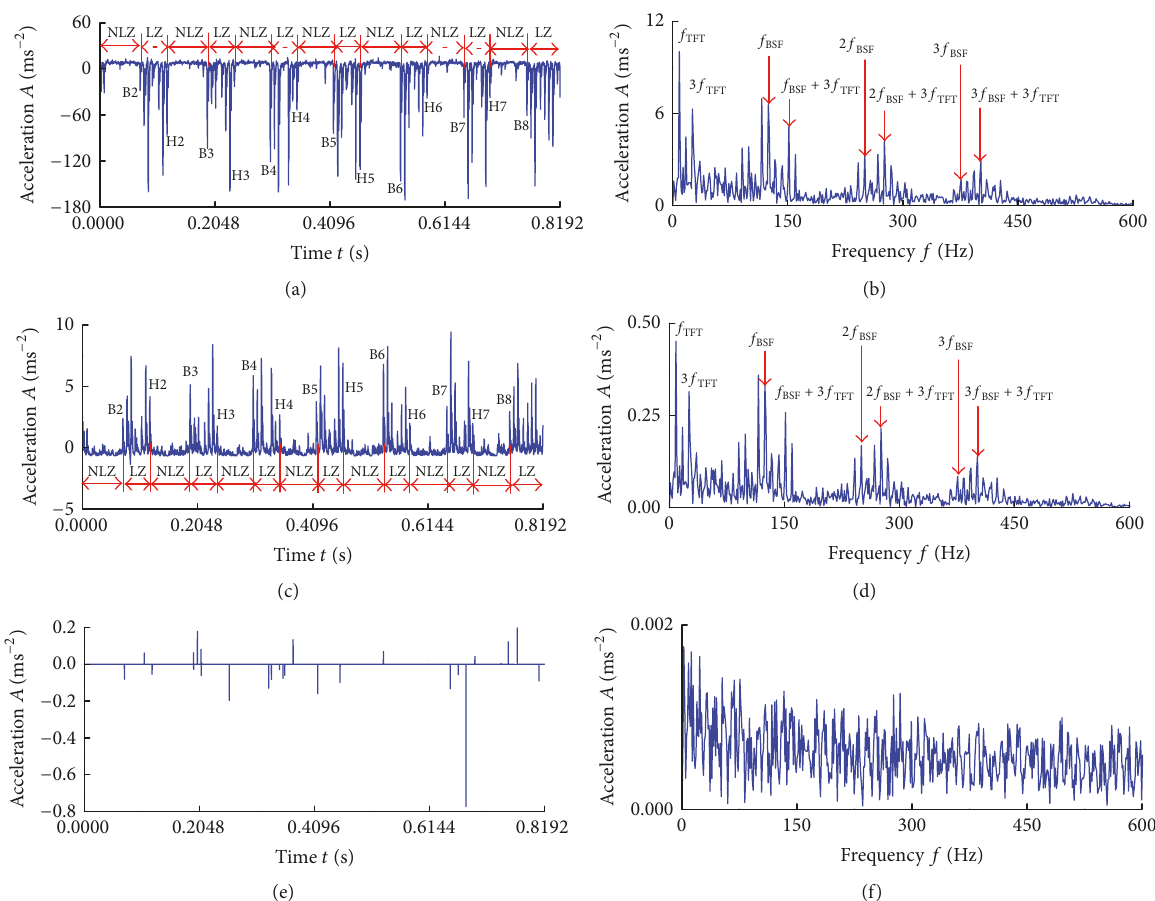
Figure18:Theintrinsicenvelopeextractedbytheimpulse-envelopemanifoldcorrespondingtoatom1:(a)theimpulse-envelopewithIsomap, (b) the Hilbert envelope spectra of (a), (c) the impulse-envelope with LLC, (d) the Hilbert envelope spectra of (c), (e) the impulse-envelope with LTSA, and (f) the Hilbert envelope spectra of (e).